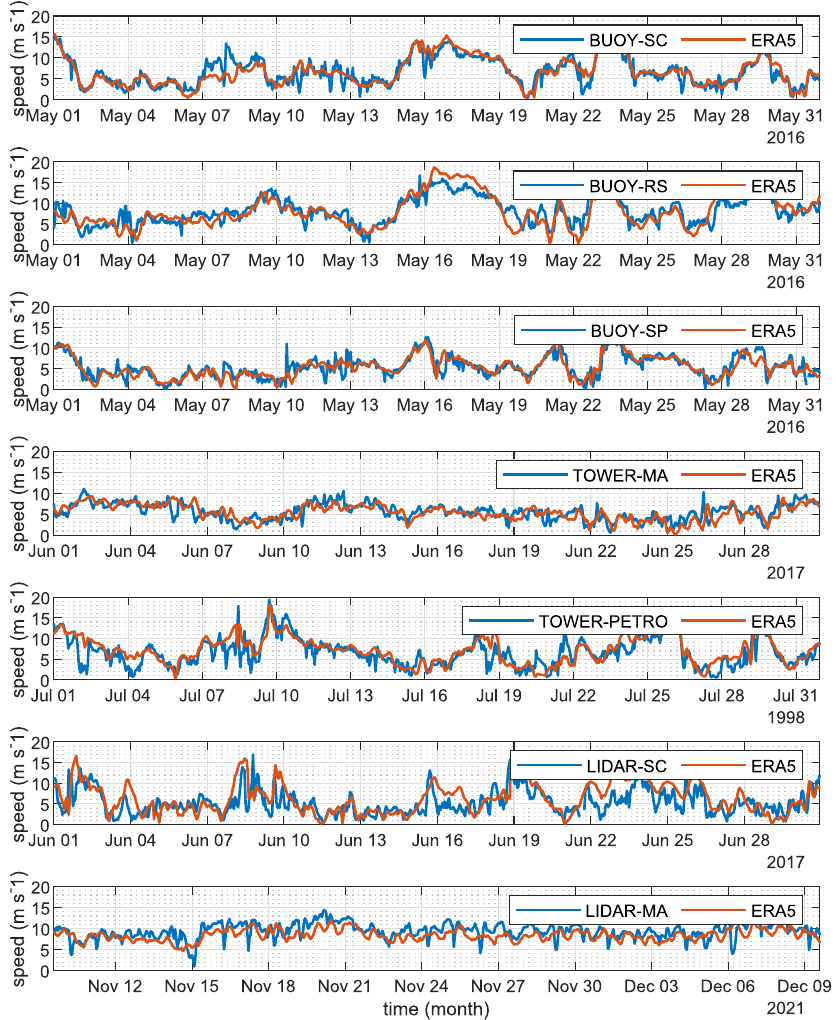
Figure 3. Wind speed time series comparing observations (blue) with ERA5 reanalysis (orange). Observational data were adjusted for height. Buoy data were adjusted to 10 m and towers and LIDAR to 100 m for comparison with ERA5 data. From top to bottom, the stations are BUOY-SC, BUOY-RS, BUOY-SP, TOWER-MA, TOWER-PETRO, LIDAR-SC, and LIDAR-MA. The results in Table 2 are comparable to those of other studies. Gualtieri (2022) described median values of R = 0.86 and RMSE = 2.04 m s − 1 for offshore stations [26]. Tavares et al. (2022) found correlations of R = 0.50 to 0.57 and RMSE = 1.05 to 1.91 m s − 1 for buoys off Rio de Janeiro and R = 0.95 and RMSE = 0.88 m s − 1 for a 35-m tower